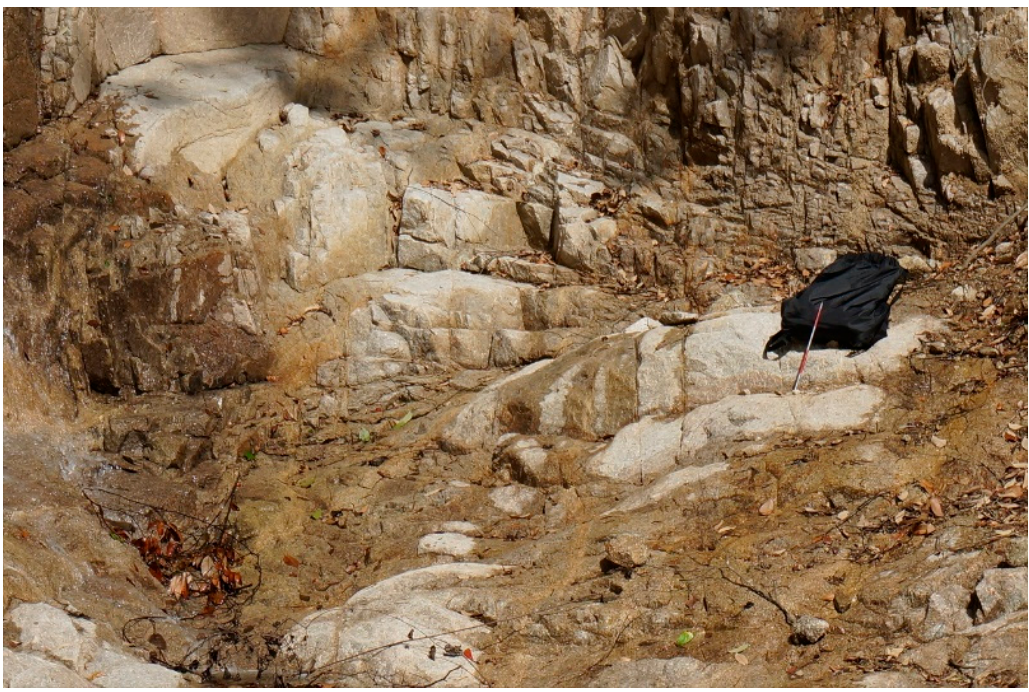
Figure 9. Many joints are formed in the base granite rock in the Asaminami, Hiroshima area.